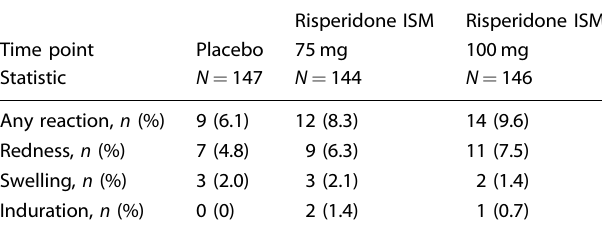
Table 4. Evaluation of injection site reactions (safety population).